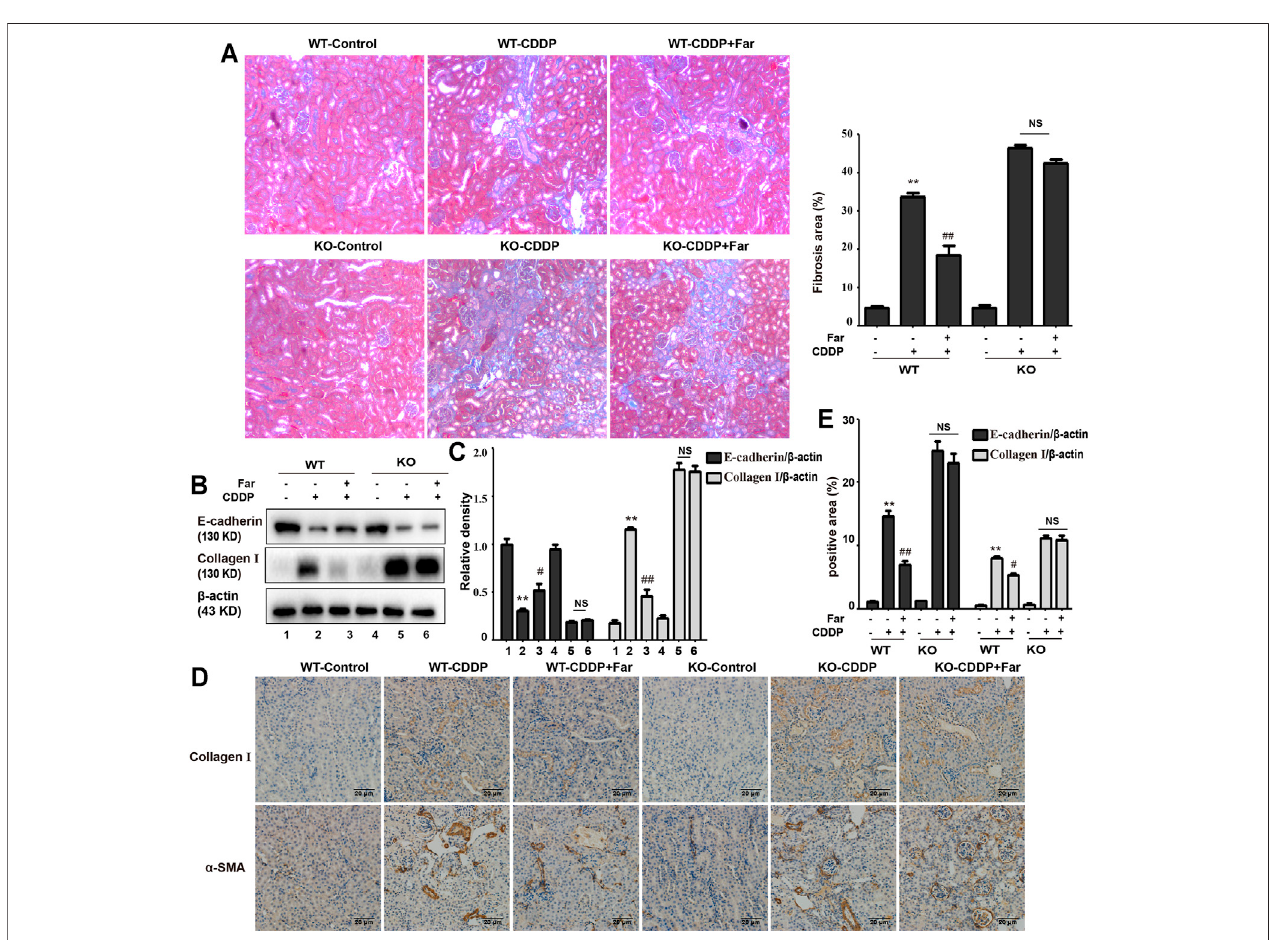
FIGURE 6 | Nrf2 knockout exacerbates CDDP-induced renal fi brosis. (A) Masson staining was utilized to show the fi brotic areas in the kidneys of different CDDP- CKD mice. A quantitative analysis of fi brosis area in the kidney tissue. (B,C) Western blotting images and quanti fi cation of E-cadherin and collagen I in mouse kidney tissue lysates normalized to β -actin. (D) Representative images of collagen I and α -SMA immunohistochemical analysis of mouse kidneys. (E) A quantitative analysis of collagen I and α -SMA positive area in the kidney tissue. Data are shown as mean ± SEM. All experiments were conducted three times. * p < 0.05 and ** p < 0.01 comparedwiththecontrolgroup; # p < 0.05and ## p < 0.01comparedwiththeCDDPgroup.NS,nospeci fi city;WT,wild-typeC57BL/6mice;KO,Nrf2knockoutC57BL/ 6